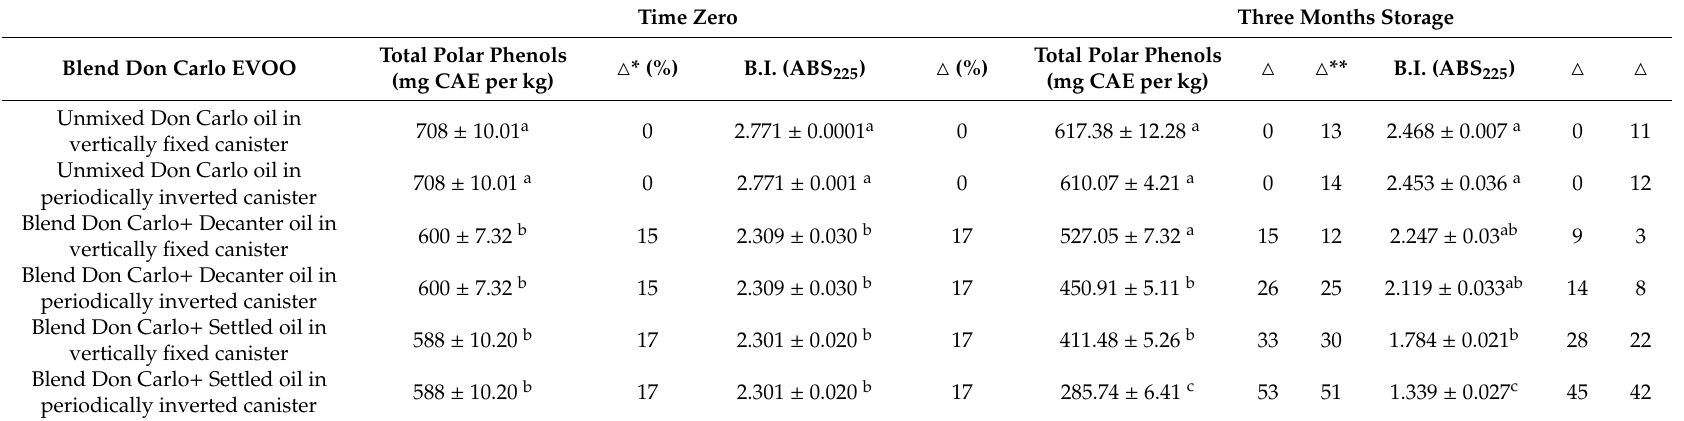
Table 4. Total polar phenol content and decay in Bitterness Index in the unmixed and blended Don Carlo EVOO during storage. Time Zero Three Months